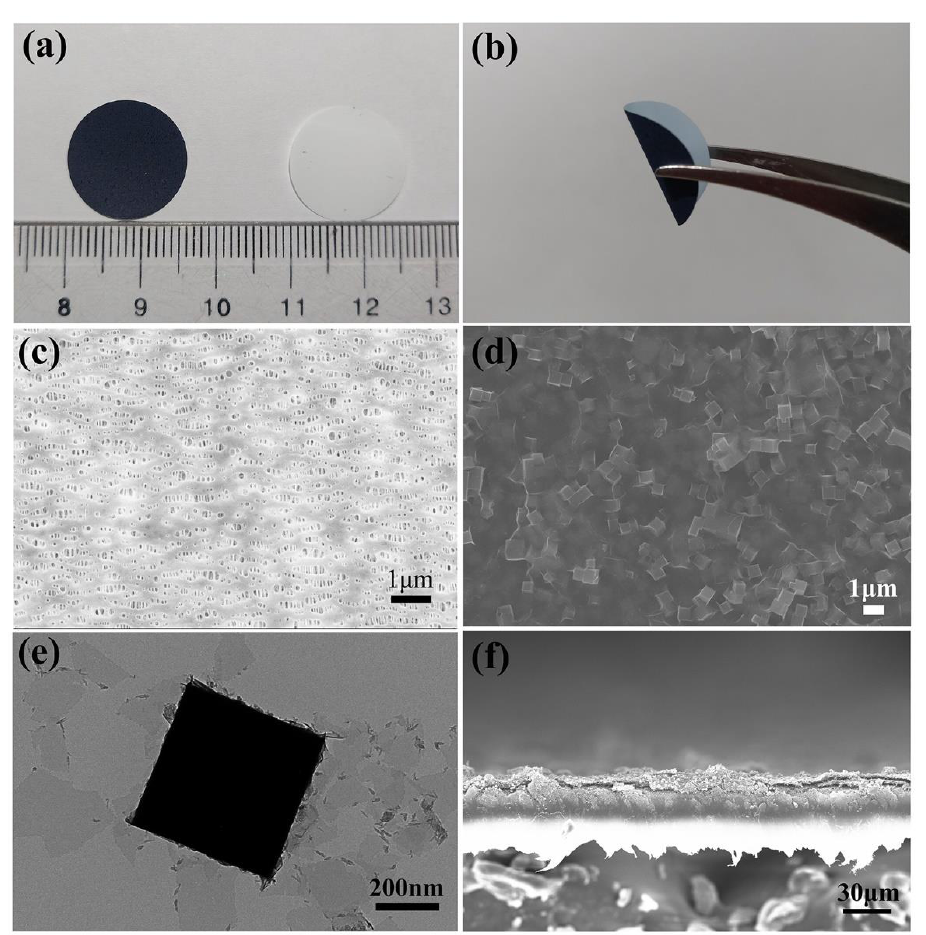
Figure 2. ( a ) Optical images of CNT+PB@Mxene/PP (left) and PP separator (right), ( b ) Bend image of CNT+PB@Mxene/PP, ( c , d ) SEM images of PP, CNT+PB@Mxene/PP, ( e ) TEM of Mxene@PP, ( f ) Cross-sectional SEM image of CNT+PB@Mxene/PP.